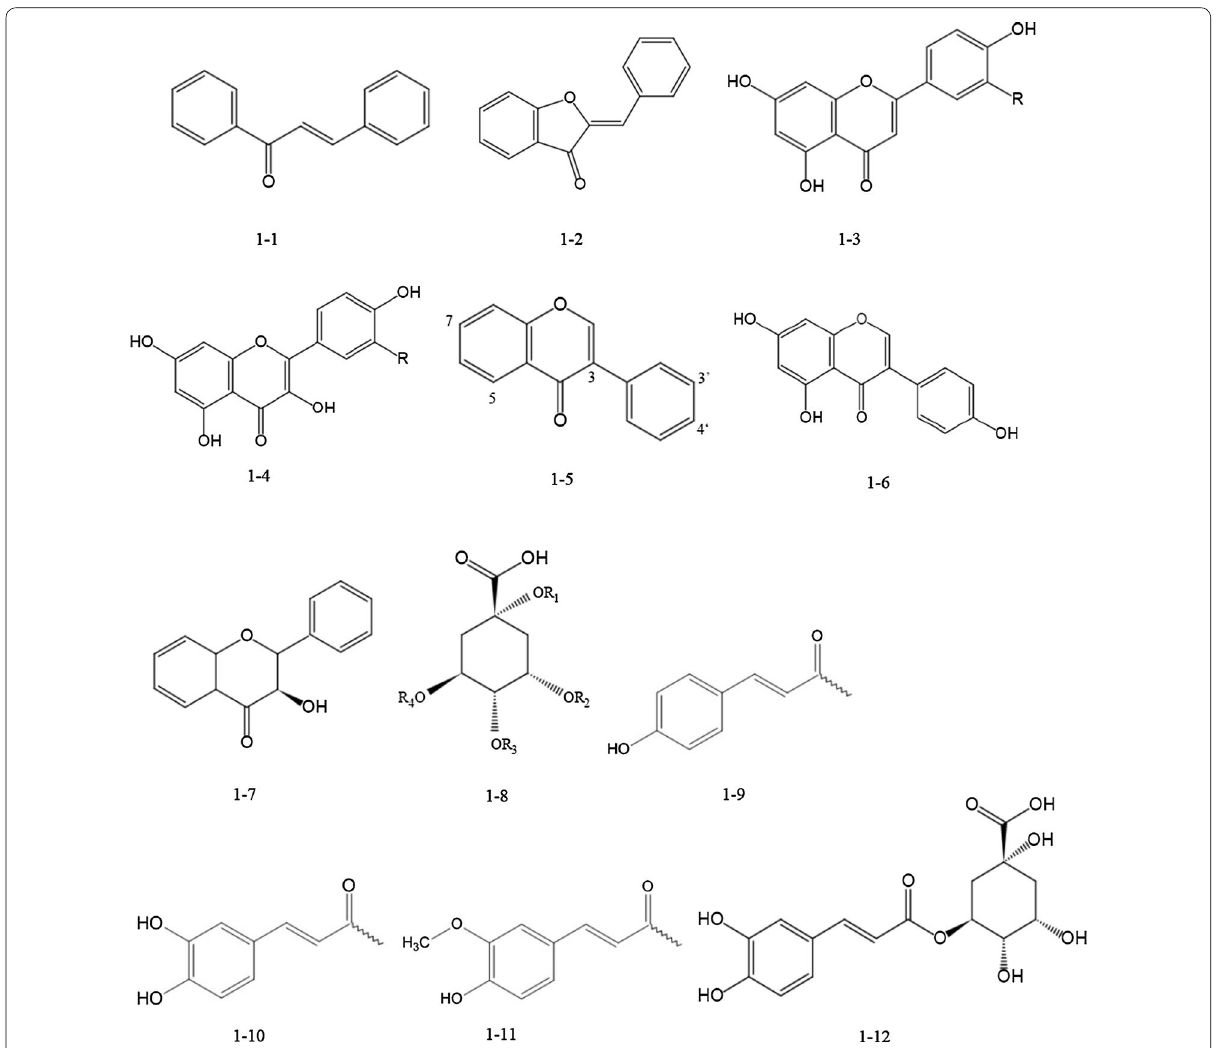
Fig. 1 Structures of chemical components of Asteraceae. Chalcone [1-1], aurone [1-2], flavone: R kaempferol, R OH quercetin [1-4], isoflavone [1-5], isoflavone (genistein) [1-6], dihydroflavonol [1-7], R 1 , R 2 , R3, R 4 = (pCo)[1-9], caffeoyl (C) [1-10], feruloyl (F) [1-11], 5-O-caffeoylquinic acid